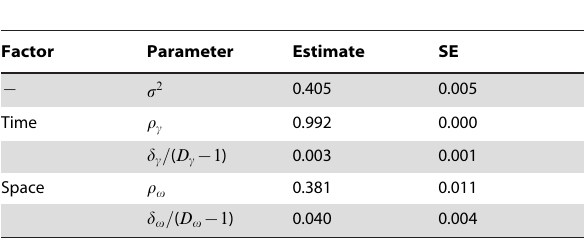
Table 5. Final Kronecker product LEAR structure correlation model estimates for caudate